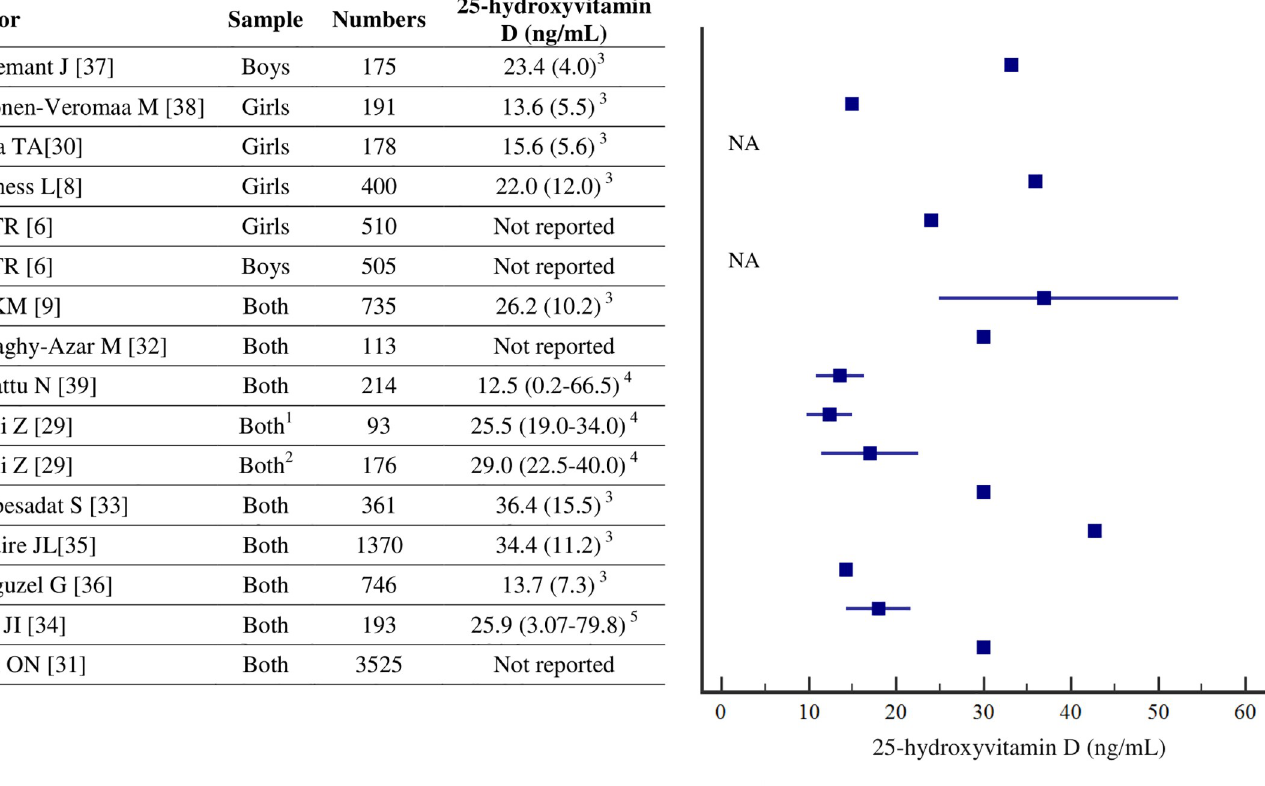
Fig 3. Thresholds defined in other studies. 1 Overweight/obese, 2 Normal weight, 3 Mean (SD), 4 Median (IQR), 5 Mean (range).